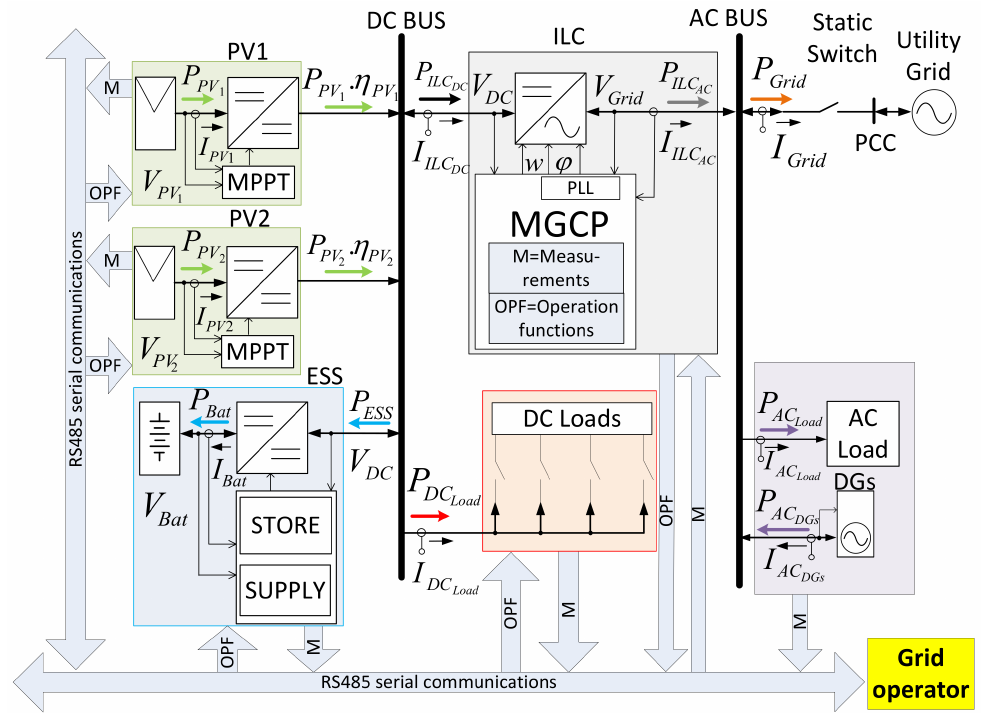
Figure 1. Conceptual scheme of the hybrid AC/DC microgrid under